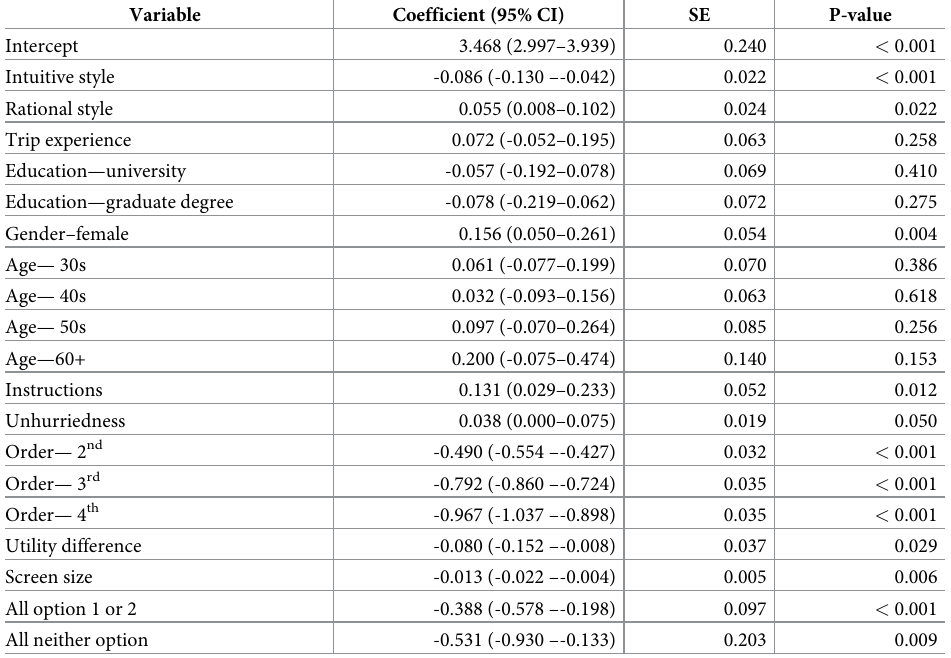
Table 5. Model of factors predicting response